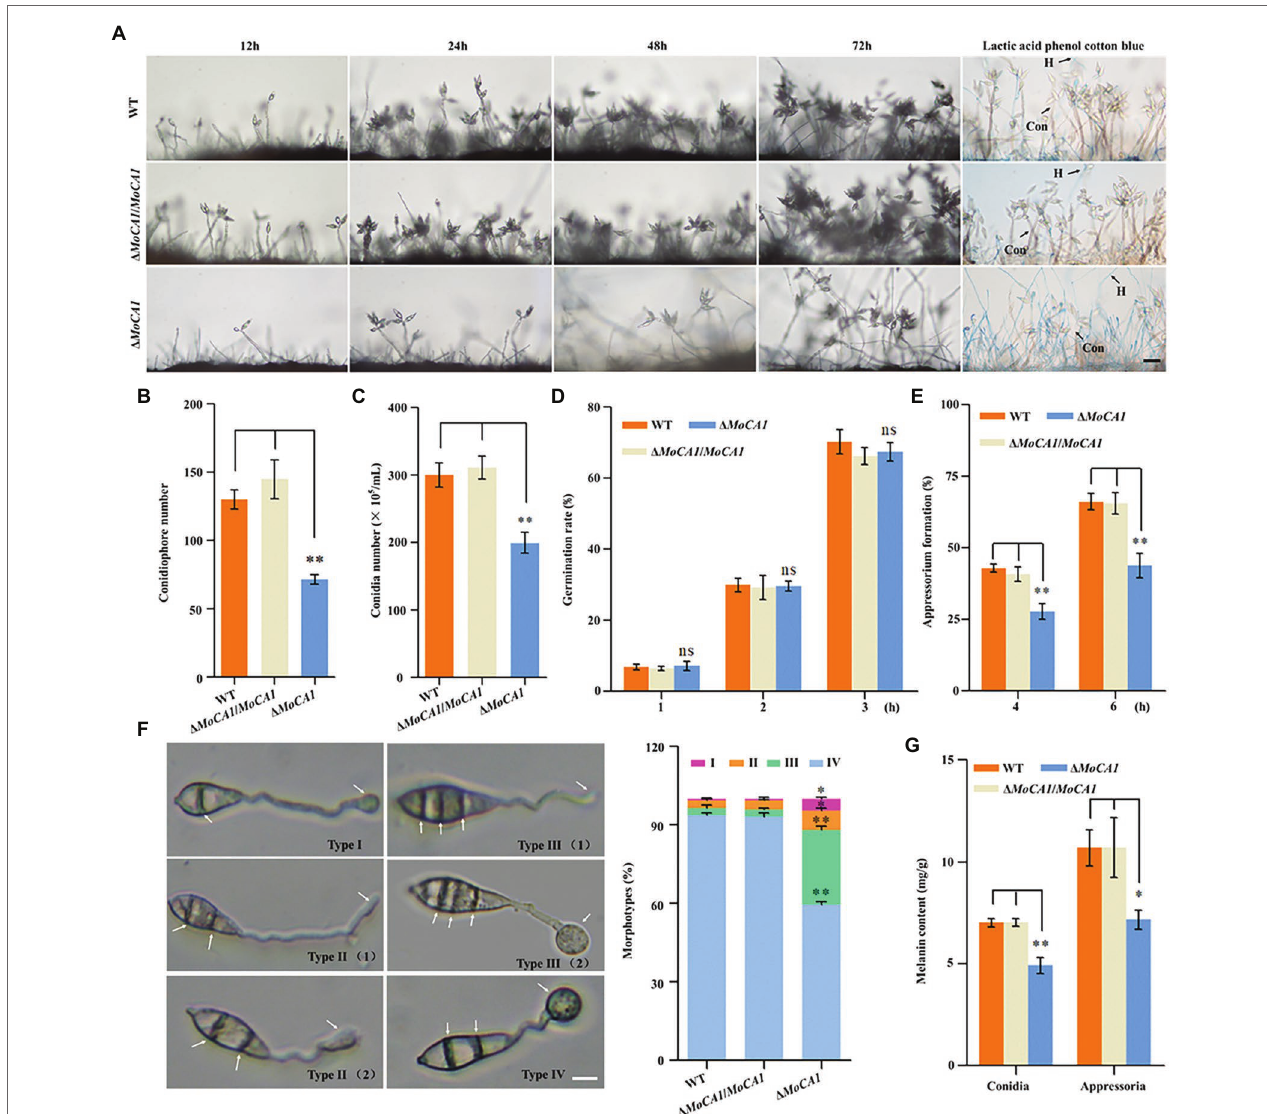
FIGURE 3 | Conidia and appressoria development analysis of the wild-type and mutant strains. (A) Conidiophore stalks stained with lactophenol cotton blue. The conidiophores of the wild type, the Δ MoCA1 , and Δ MoCA1 / MoCA1 strains induced for 12, 24, 48, and 72 h; strains were stained with lactophenol cotton blue at 72 h. The hyphae are stained blue, whereas the conidiophore stalks are in gray. Bar = 50 μ m. (B) Statistical analysis of the conidiophores number of the wild type, the Δ MoCA1 , and Δ MoCA1 / MoCA1 mutant strains. (C) Statistical analysis of conidial production in the strains. (D) Conidial germination rate. Conidial germination was calculated under the microscope at 1, 2, and 3 h. (E) Appressorial formation rate. Appressorial formation was calculated under the microscope at 4 and 6 h. (F)